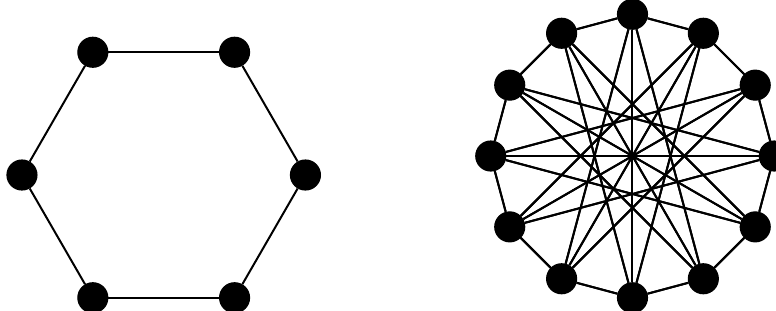
Figure 3. Circ ( 6,1 ) and Circ ( 12,1,5,6,7 ) admit efficient dominating